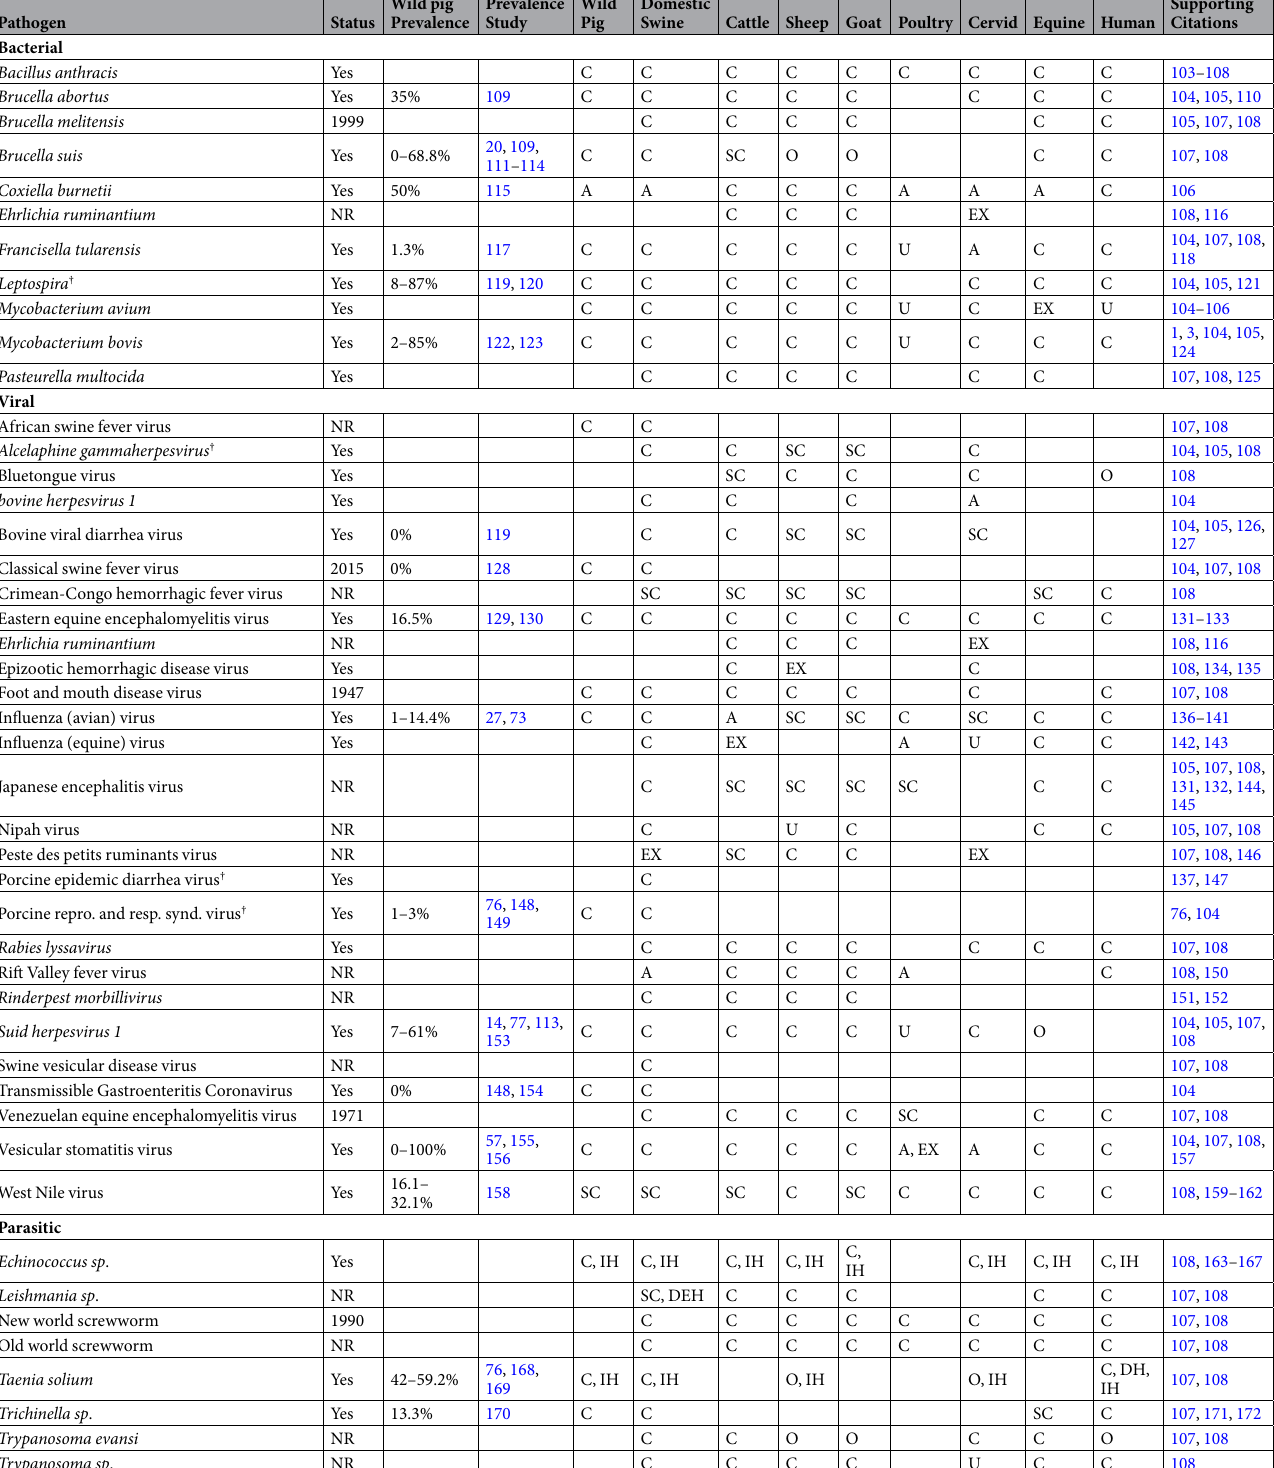
Table 2. Susceptibility of seven host species to OIE listed swine pathogens. The table presents the results of the host susceptibility classification for 45 pathogens known to impact swine. In addition, the known status (present/absent) of the pathogens in North American wild pigs along with the reported prevalence range are included. If the pathogen was historically present but has been eradicated from North America the year of eradication is provided and pathogens never reported are indicated as NR. Wild pigs are included specifically to identify gaps in available scientific data for differences in susceptibility between domestic swine and wild pigs. Pathogens noted with † were not OIE listed at the time of analysis however are included here for completeness and were not included in network